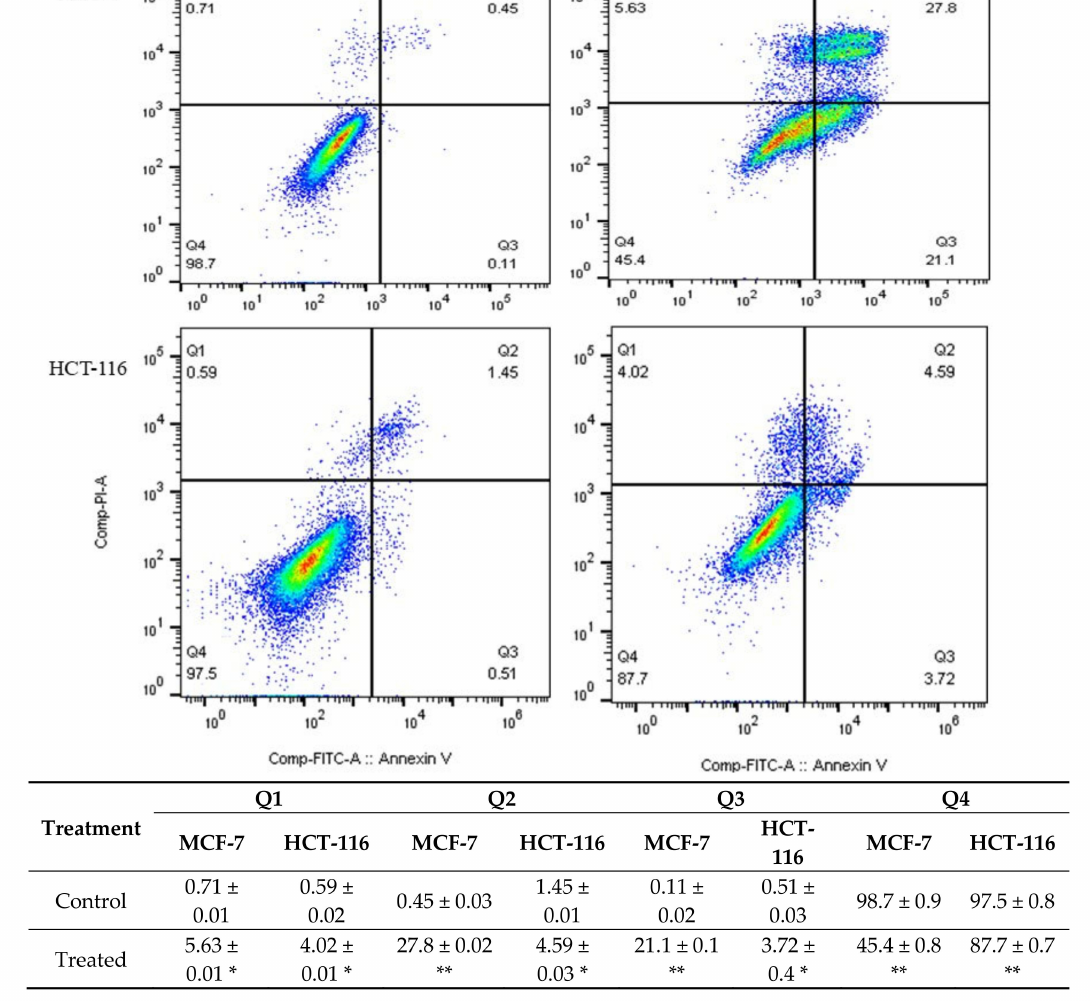
Figure 2. The level of apoptosis and necrosis was assessed by flow cytometry using Annexin V / PI staining, the control groups were without any treatment, and the M. fruticosa extract groups were treated with 100 µ g / mL M. fruticosa extract for 48 h, * p < 0.05, ** p < 0.001. Q1: necrotic cells, Q2,